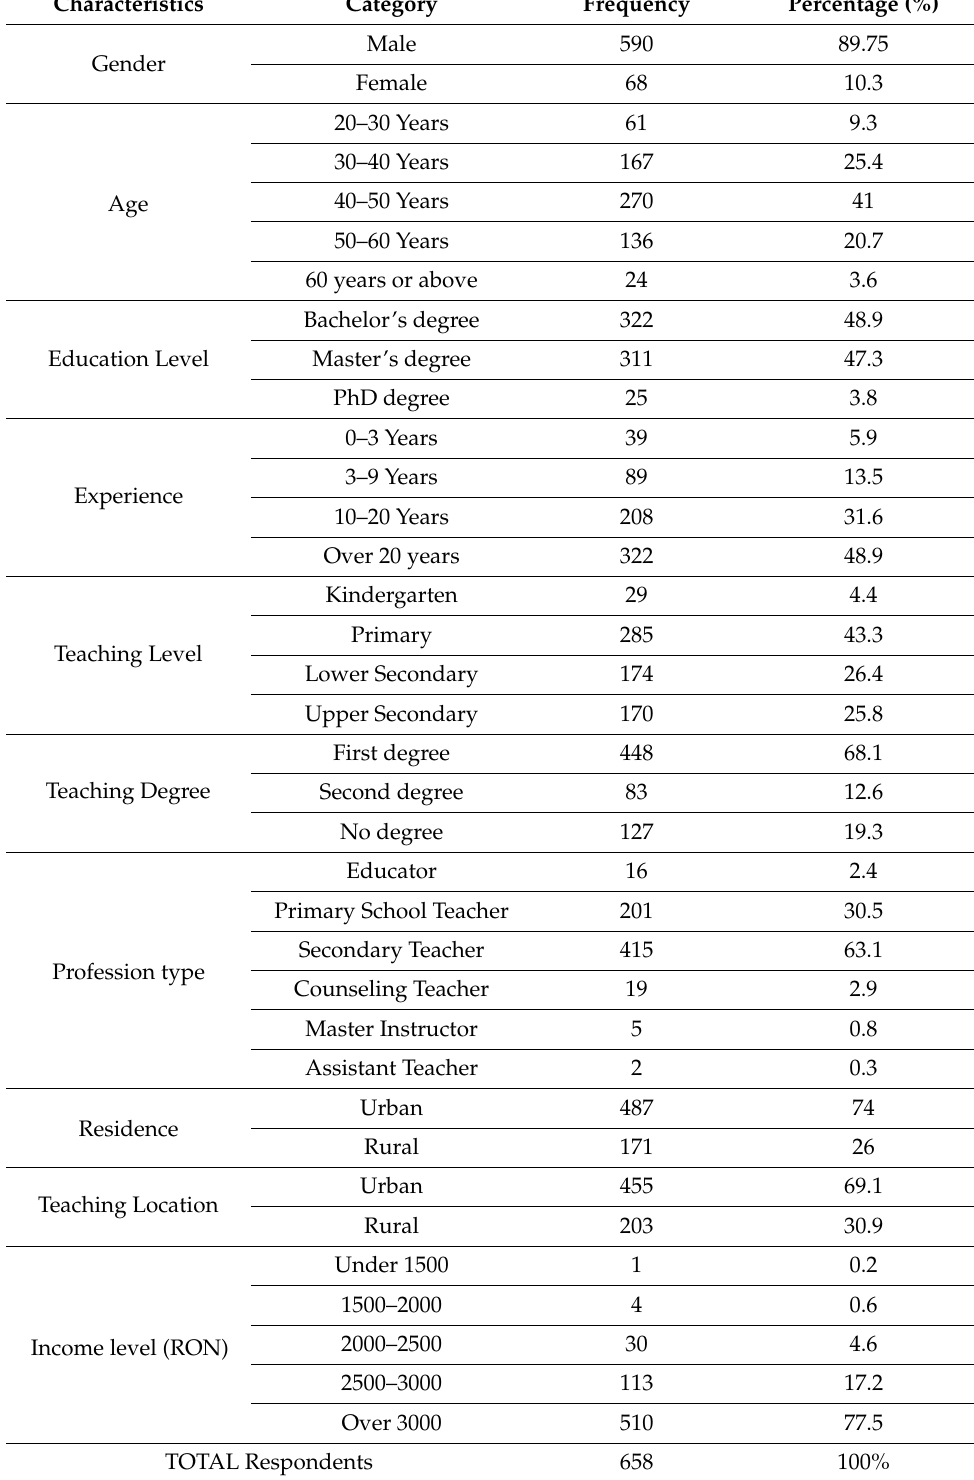
Table 1. Respondent